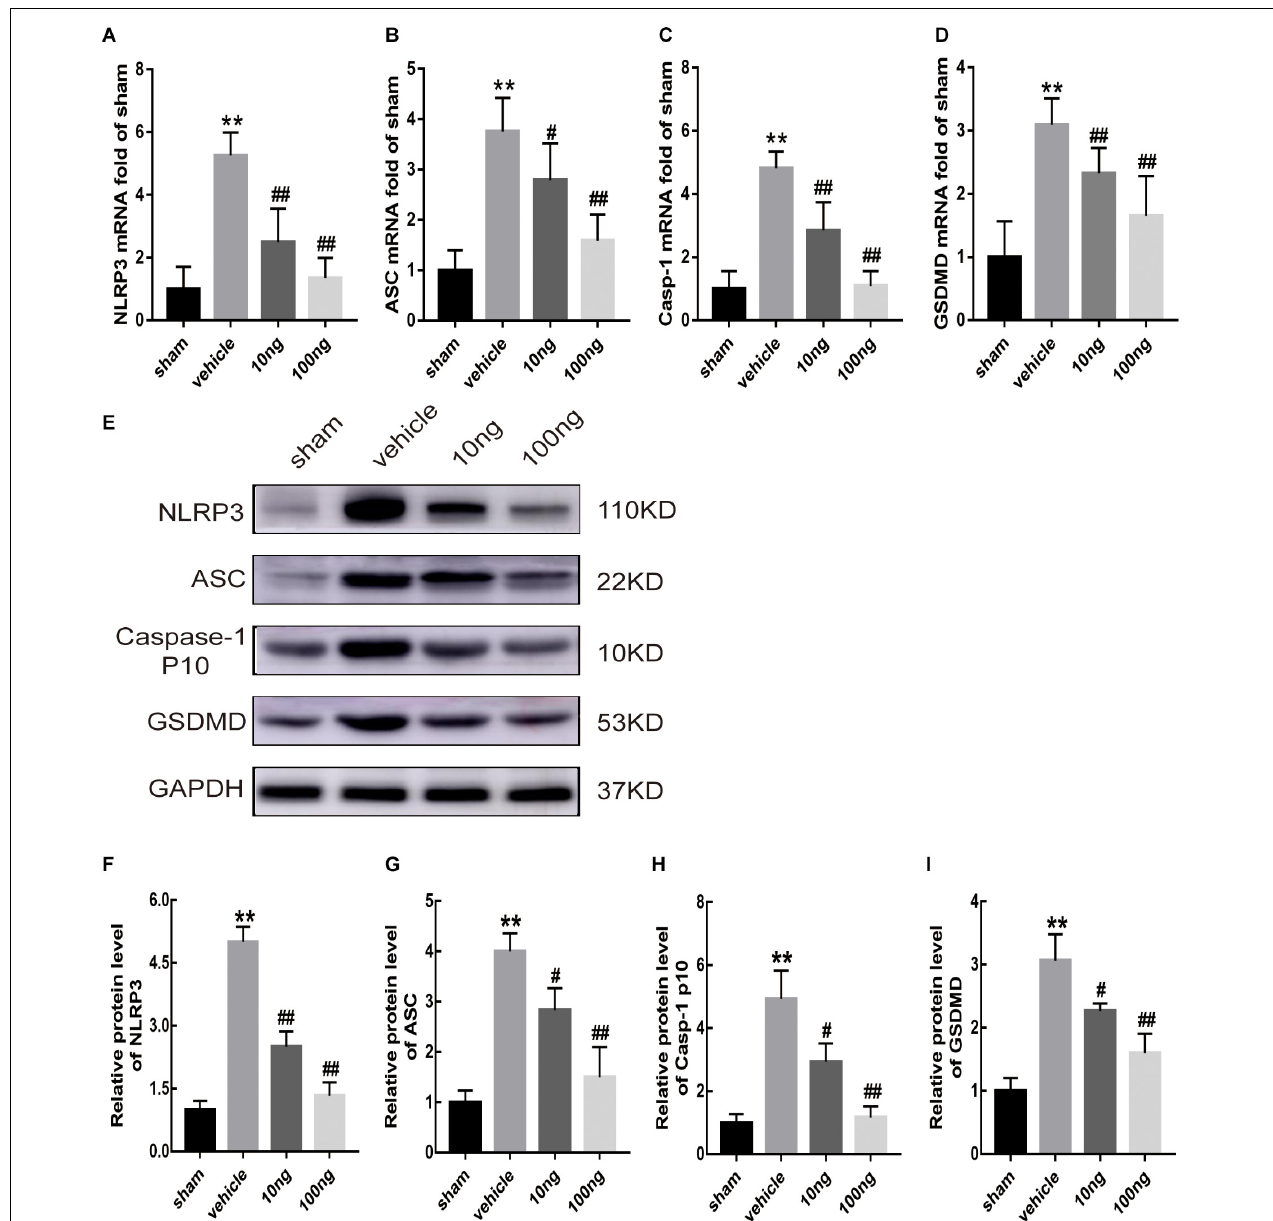
FIGURE 3 | MaR1 inhibited the mRNA and protein expressions of inflammasome and pyroptosis indicators in spinal cord ( n = 6/group). The inflammasome and pyroptosis indicators’ expression levels were determined by qRT-PCR and Western blot analysis. (A–D) MaR1 (10 or 100 ng) reversed the rising mRNA levels of NLRP3, ASC, Caspase-1, and GSDMD induced by NCLDH. (E–I) MaR1 (10 or 100 ng) reversed the increased protein levels of NLRP3, ASC, Caspase-1, and GSDMD induced by NCLDH. Data are presented as the mean ± SD (** P < 0.01 versus the sham group; ## P < 0.01 versus the vehicle group; # P < 0.05 versus the vehicle